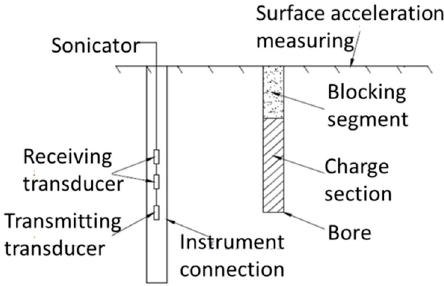
Figure 16. The arrangement of wave velocity test and blasting test.